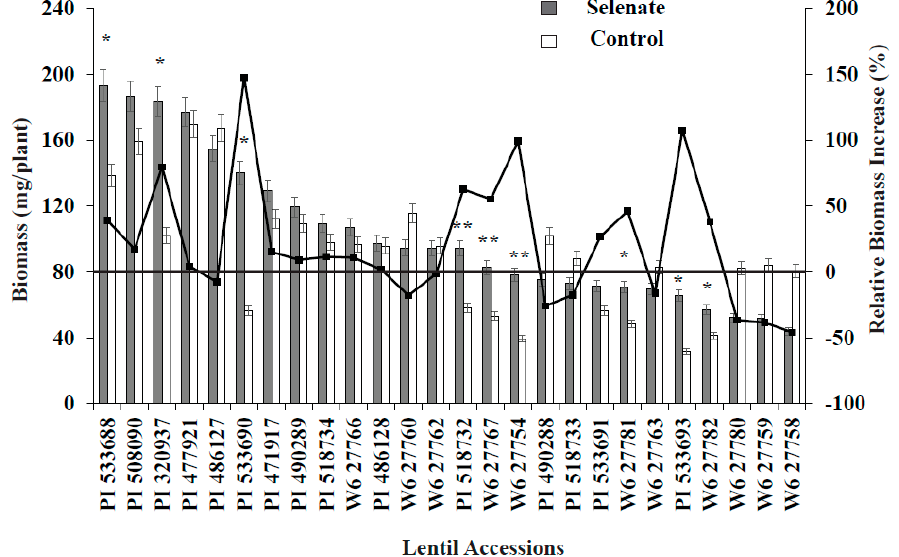
Figure 1. Variation in biomass and relative biomass change for 26 lentil genotypes during germination with added Se fertilizer. *, ** = Significant at p < 0.05 and p < 0.1, respectively. Relative biomass was calculated based on control biomass weight.